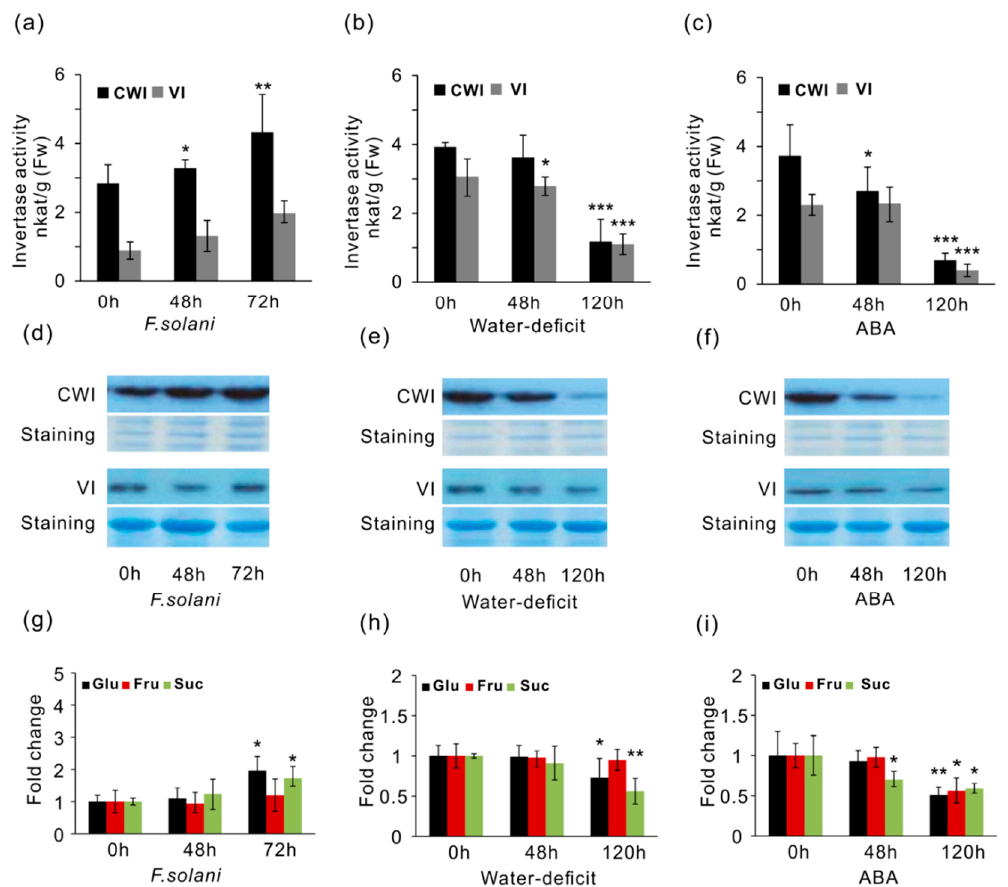
Figure 8. Effects of acid invertase activities, proteins, and soluble sugar accumulation. CWI and VI activities ( a – c ), proteins ( d – f ), and soluble sugar (glucose, fructose, and sucrose) content ( g – i ) were inspected in response to F. solani , water-deficit and ABA. Polyclonal antibodies of CWI and VI were generated from BvVI1 and BvCWI-1 in sugar beet. Data of enzyme activities represent means ±SE of at least four independent biological replicates. Data of sugar quantification represent mean ±SE of at least six biological replicates. Asterisks indicate significant differences in comparison with the control using Student’s t -test: p < 0.001 (***), p < 0.01 (**), p < 0.05 (*).